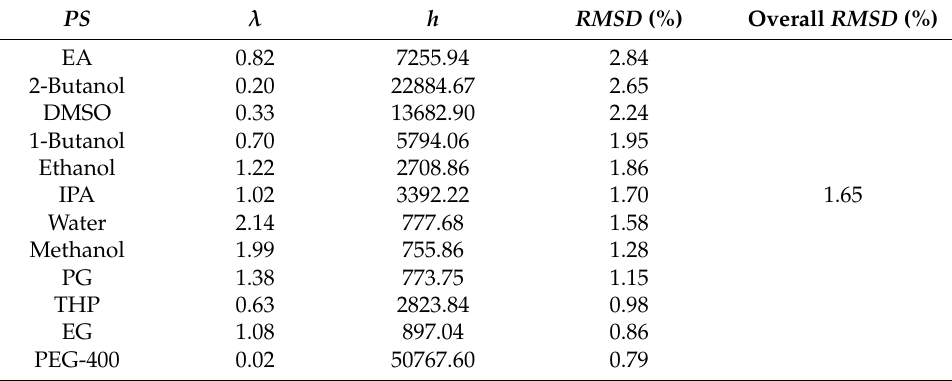
Table 7. Results of the Buchowski-Ksiazaczak λ h model in terms of model parameters ( λ and h ) and RMSD for ECT in various PS d